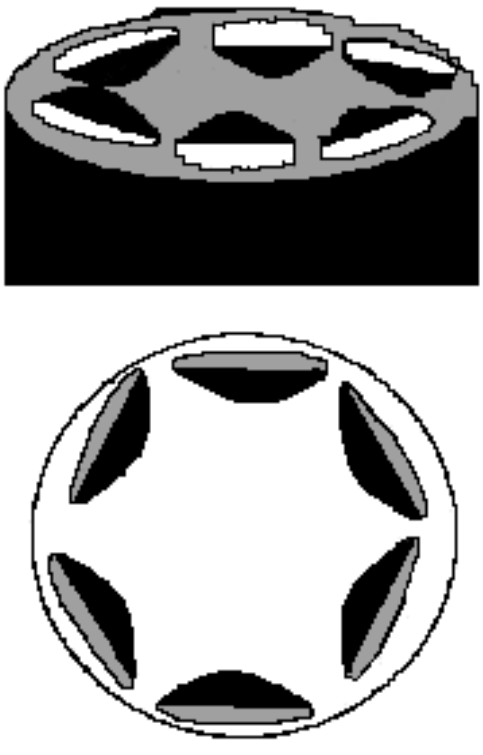
Figure 9. Proposed cylindrical arrangement of BS into reverse hexagonal liquid crystalline phases. Each unit represents a BS , with polar regions, in black, pointing toward the inner part of the cylinder. The structure has a six-fold symmetry axis. The above cylinders are arranged into a hexagonal